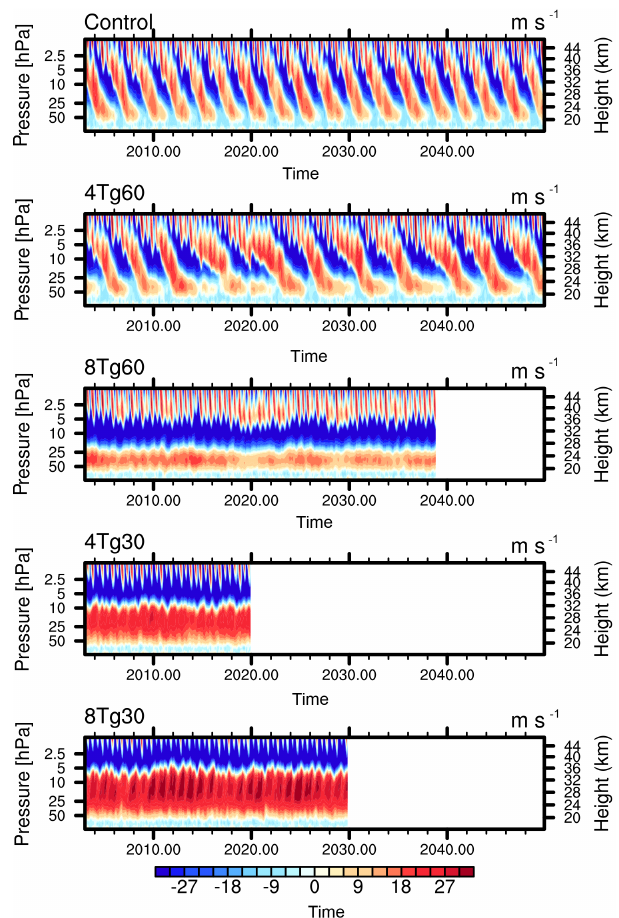
Figure 1. Zonal mean zonal wind velocity ms − 1 at the equator for the control simulation and simulations with injection rates of 4 and 8Tg ( S ) yr − 1 at a height of 60 and 30hPa. The values for height [km] at the right axes are approximations